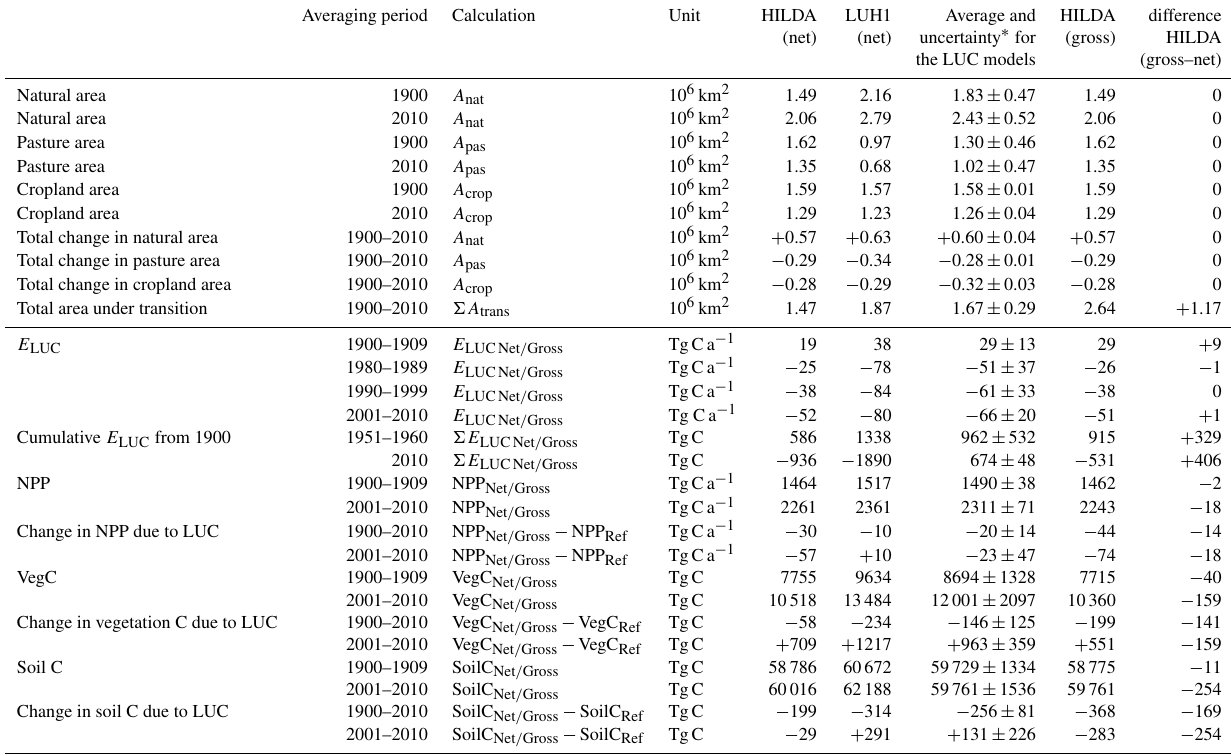
Table 4. Changes in C stocks and fluxes in reconstructions of net and gross LUC changes for Europe (EU27 + CH). Values are always given as 10-year averages (except LUC areas and cumulative